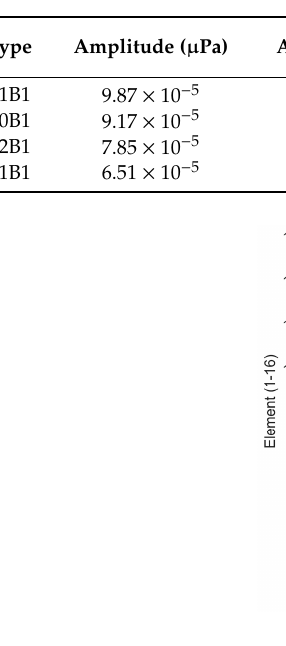
Table 2. Structure of S1B1, S0B1, and S2B1 wave.